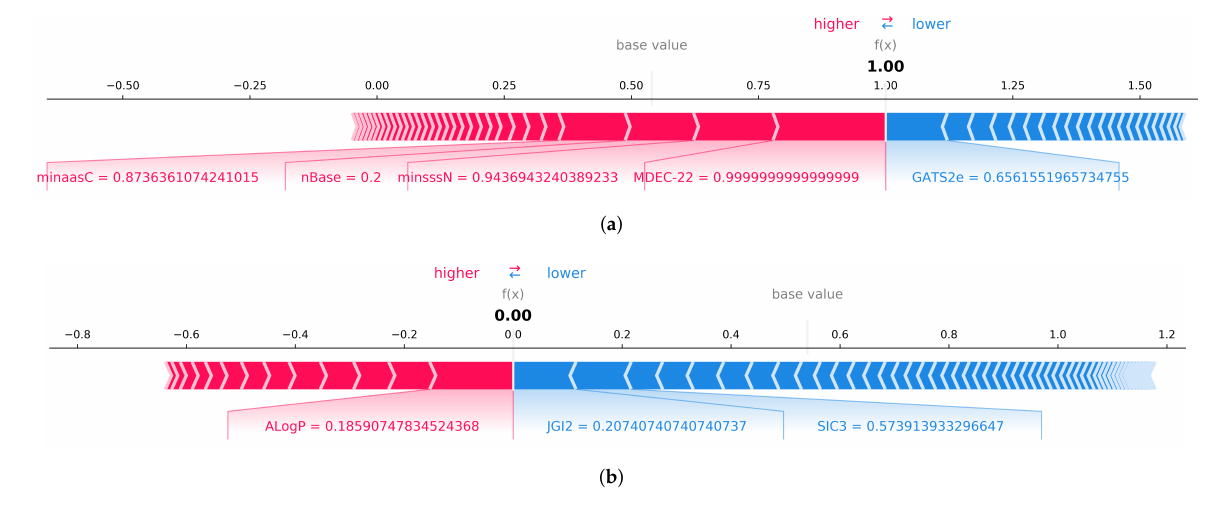
Figure 8. ( a ) Local explanation using SHAP force plot to explain a specific instance where the respiratory toxicity prediction is 1, and shows descriptors contributing towards the decision. ( b ) Local explanation using SHAP force plot to explain a specific instance where the respiratory toxicity prediction is 0.